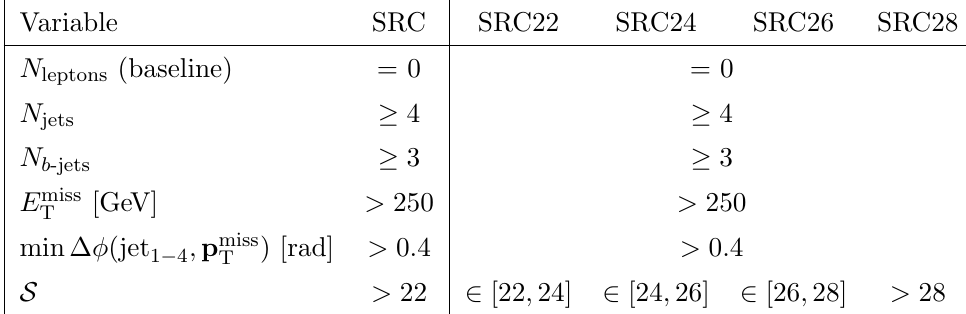
Table 3. De(cid:12)nitions for SRC, alongside the four varying S intervals used. The letter appended to the SRC label corresponds to the lower bound on the S interval. SRC targets small mass splittings between the ~ b 1 and ~ (cid:31) 0 , in the m (~ (cid:31) 0 ) = 60 GeV signal scenario. The jets and b -jets are ordered 2 1 by p T